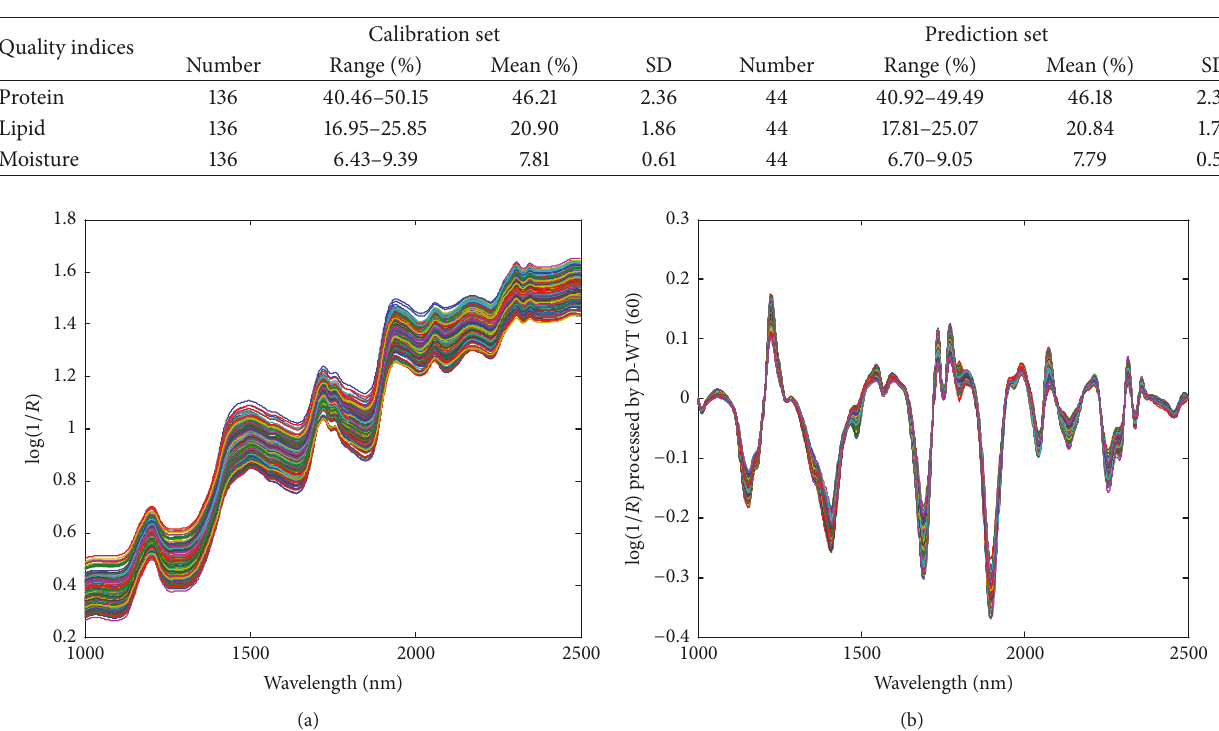
Table 1: Statistical results of calibration and prediction sets of Fuzhu quality parameters.